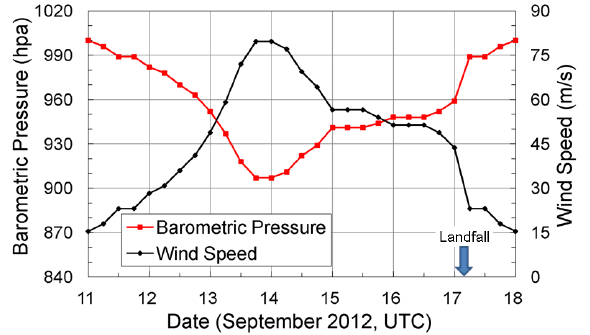
Figure 3. The central maximum wind speed and air pressure during Typhoon